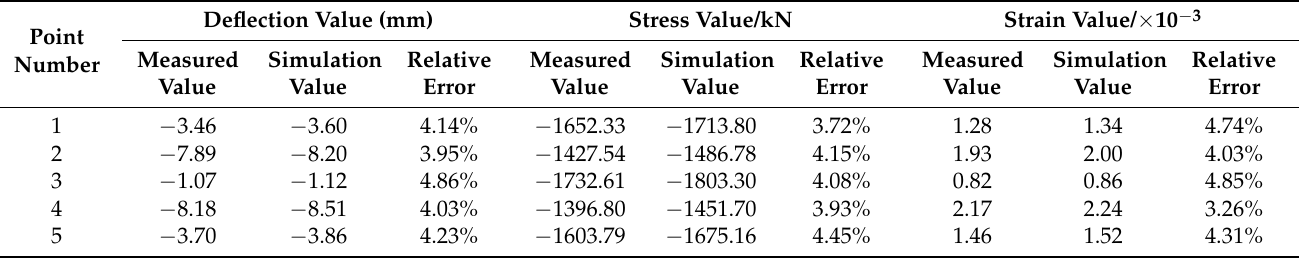
Table 1. FEM accuracy verification table. Table 1 . FEM accuracy verification table. Table 1 . FEM accuracy verification table.